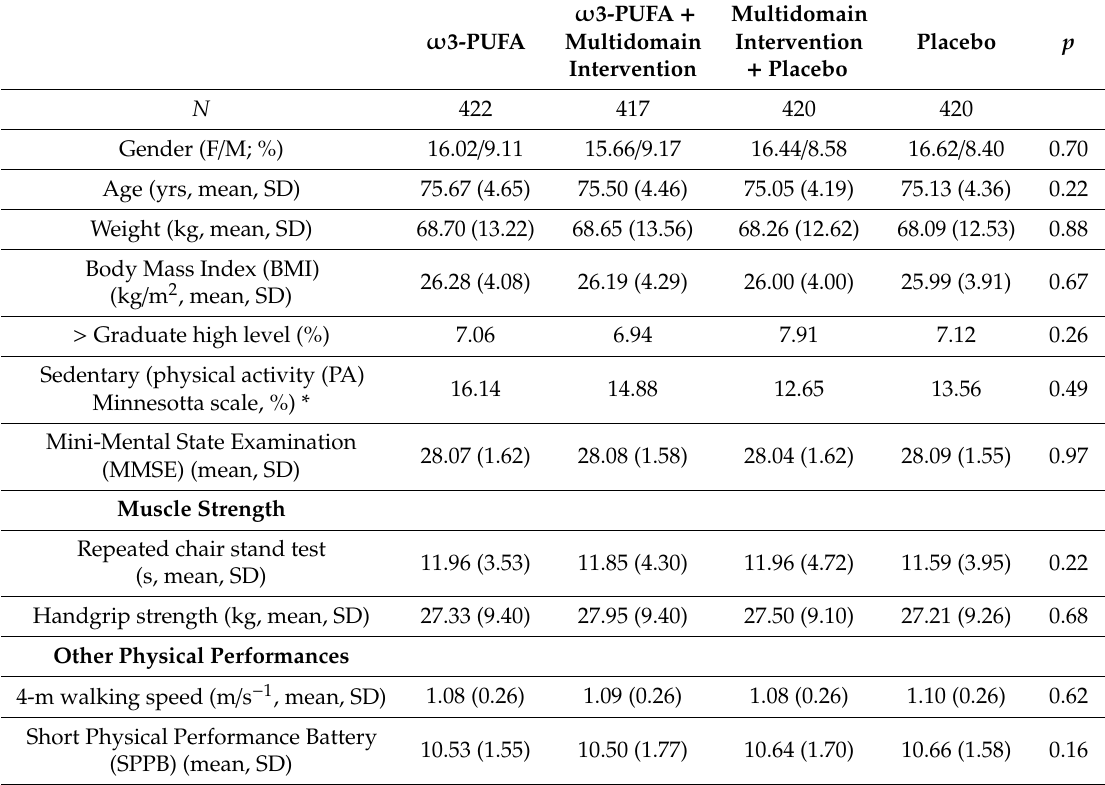
Table 1. Demographic characteristics and score of physical performance tests at baseline.